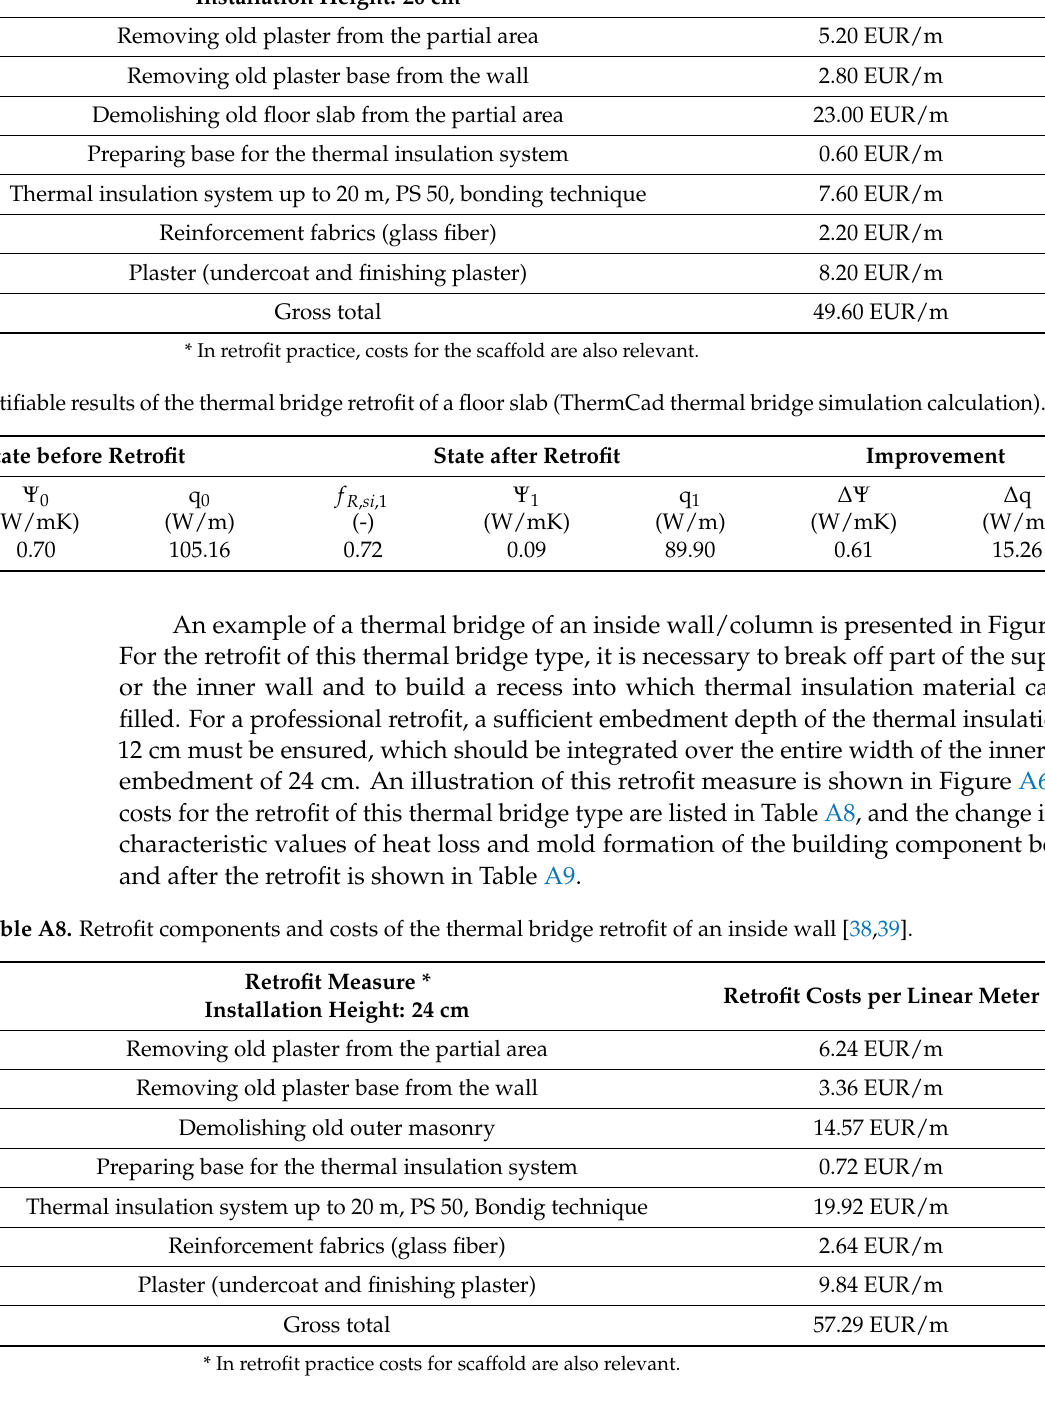
Table A6. Retrofit components and costs of the thermal bridge retrofit of a floor slab [38,39]. Pos. No.